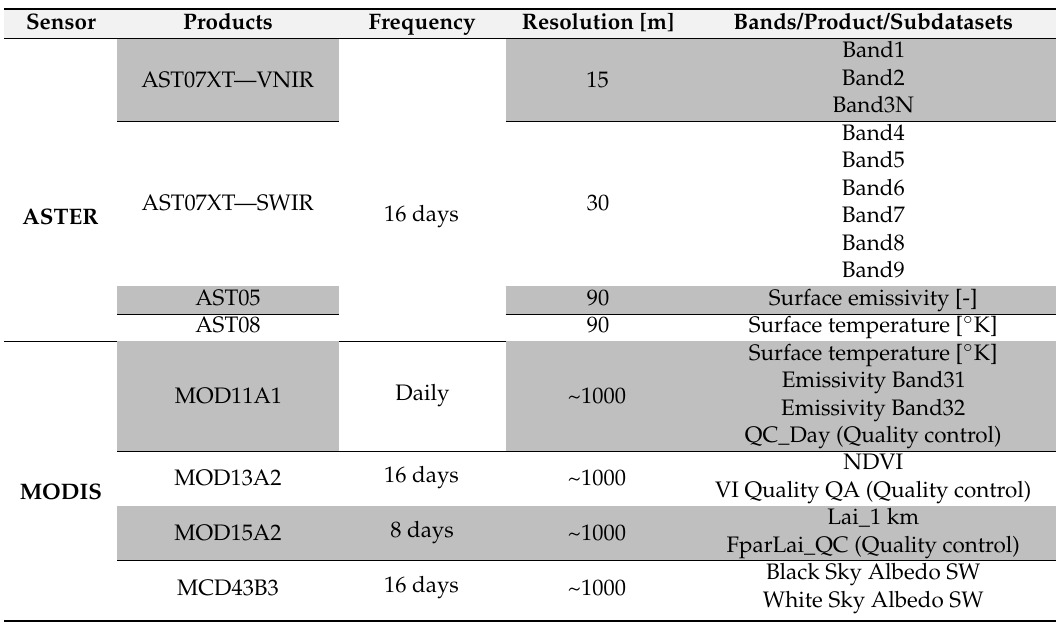
Table 1. ASTER and MODIS products used in this